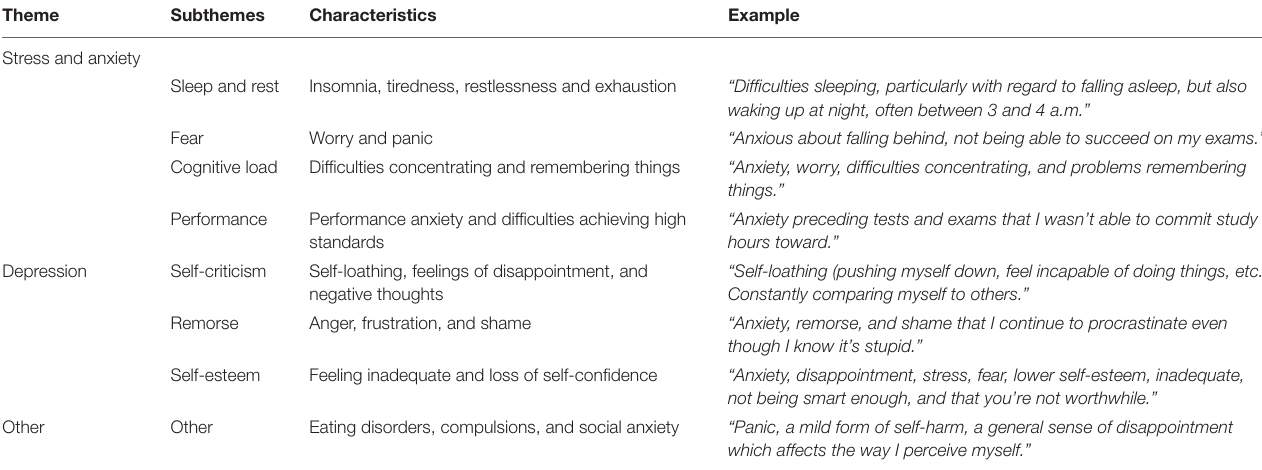
TABLE 6 | Psychological issues of procrastination. Theme Subthemes Characteristics Example Stress and